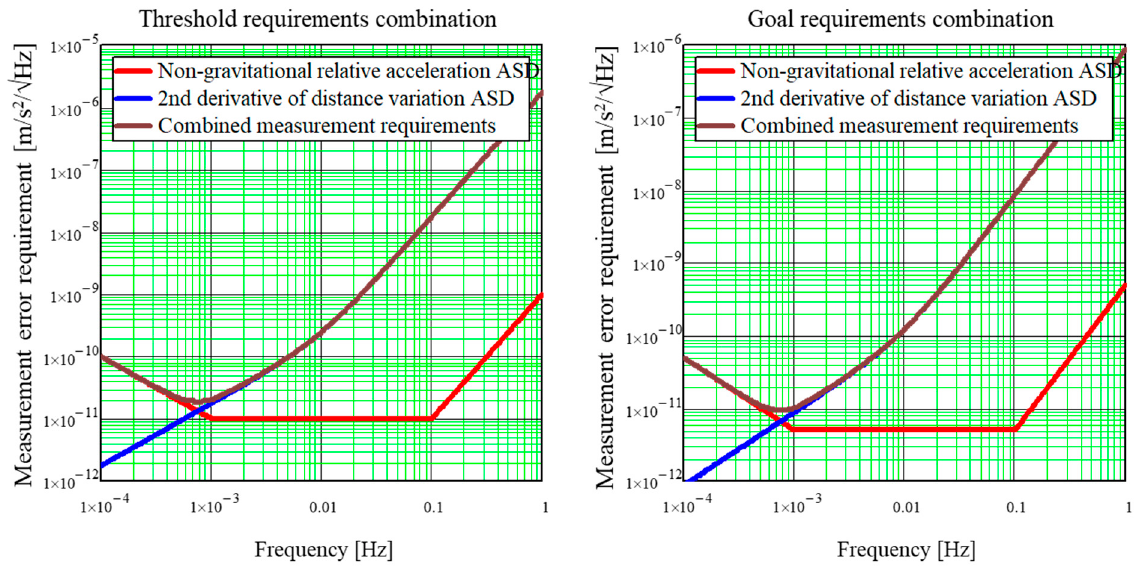
Figure 5. Combined requirements on Δ a D and on the second temporal derivative of Δ d .